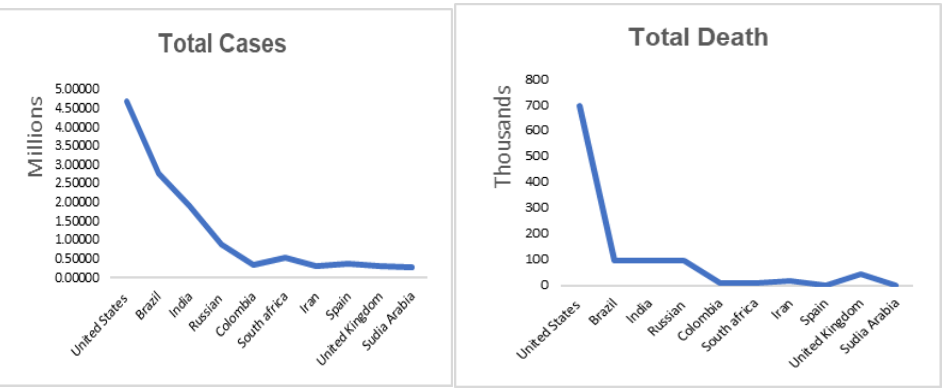
Figure 1. Distribution of COVID-19 from 22 January to 5 August 2020.